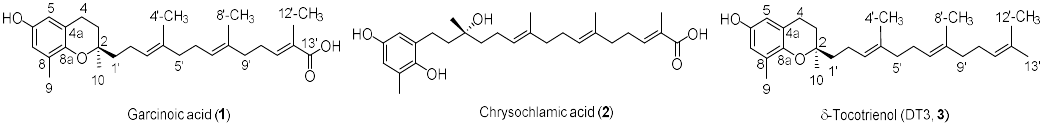
Figure 1. Structures of garcinoic acid ( 1 ), chrysochlamic acid ( 2 ), and δ-tocotrienol (DT3, 3 ).